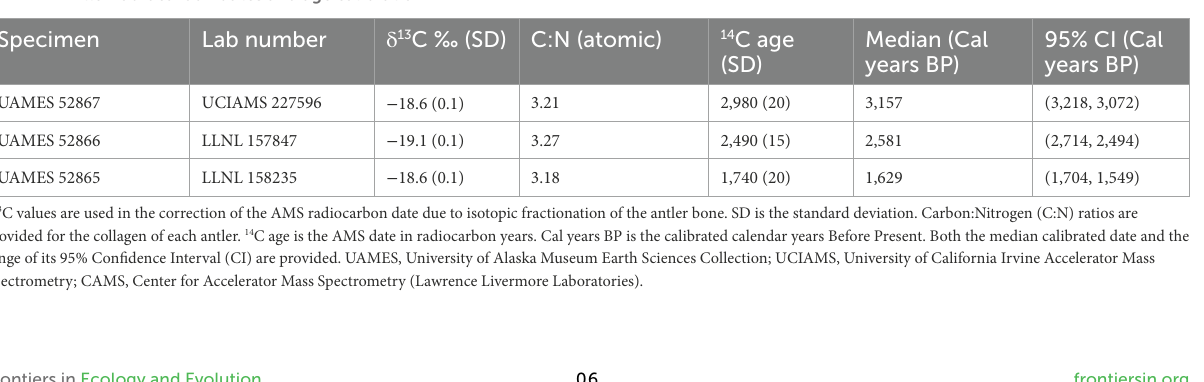
TABLE 2 Antler radiocarbon dates and age